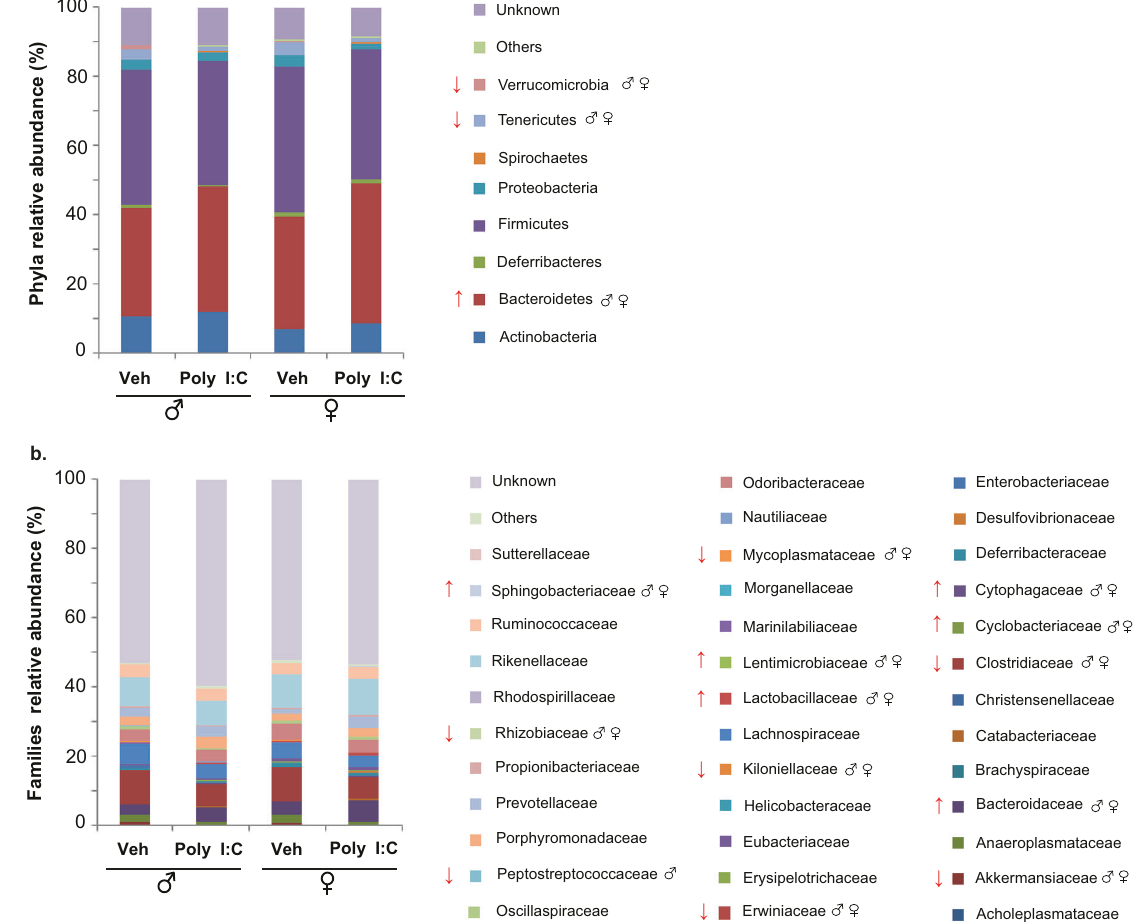
Fig. 4 Microbiota changes induced by MIA in male and female offspring at pnd 28. Mean relative abundance (%) of gut bacteria at phyla ( a ) and families ( b ) levels; ↑ signi fi cant increase, ↓ signi fi cant decrease. Two-way ANOVA with post-hoc Tukey ’ s At pnd 120, most of the differences observed between Poly I:C and Veh offspring at pnd 28 were no longer detectable. At the phylum level, similarly to pnd 28, the dominant composition of the gut microbiota was Firmicutes and Bacteroidetes , but no statistical signi fi cant differences were observed between the phyla in both sexes (Supplementary Fig. 1a). The only changes persisting at pnd 120 were those relative to the family Mycoplasmataceae as well as the genera Ureaplasma and Mycoplasma . In Poly I:C males and females, the Mycoplasma- taceae were found down-represented as compared to Veh mice [main effect of treatment: F(1,12) = 20.218, p < 0.01], Supplemen- tary Fig. 1b. At the genus level, Poly I:C offspring of both sexes revealed a signi fi cant decrease in the relative abundance of Ureaplasma [main effect of treatment: F(1,12) = 14.358, p < 0.01], and Mycoplasma [main effect of treatment: F(1,12) = 20.058, p < 0.01] together with the reduction of Alloprevotella [main effect of treatment: F(1,12) = 5.286, p < 0.05] and Parasutterella [main effect of treatment: F(1,12) = 6.575, p < 0.05] as compared to Veh mice, Supplementary Fig. 2.